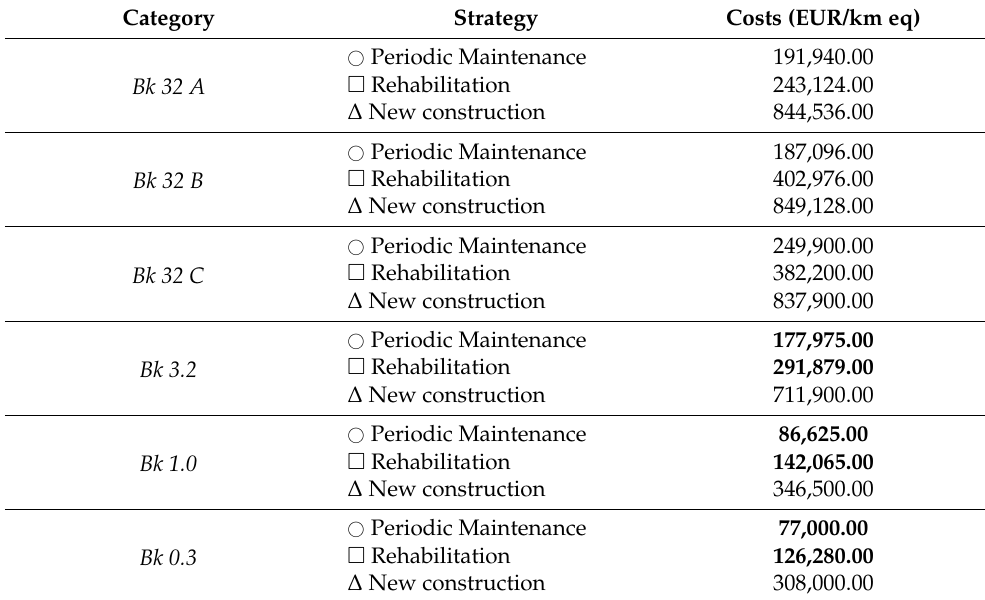
Table 5. Unit costs to repair urban pavements in Munster.